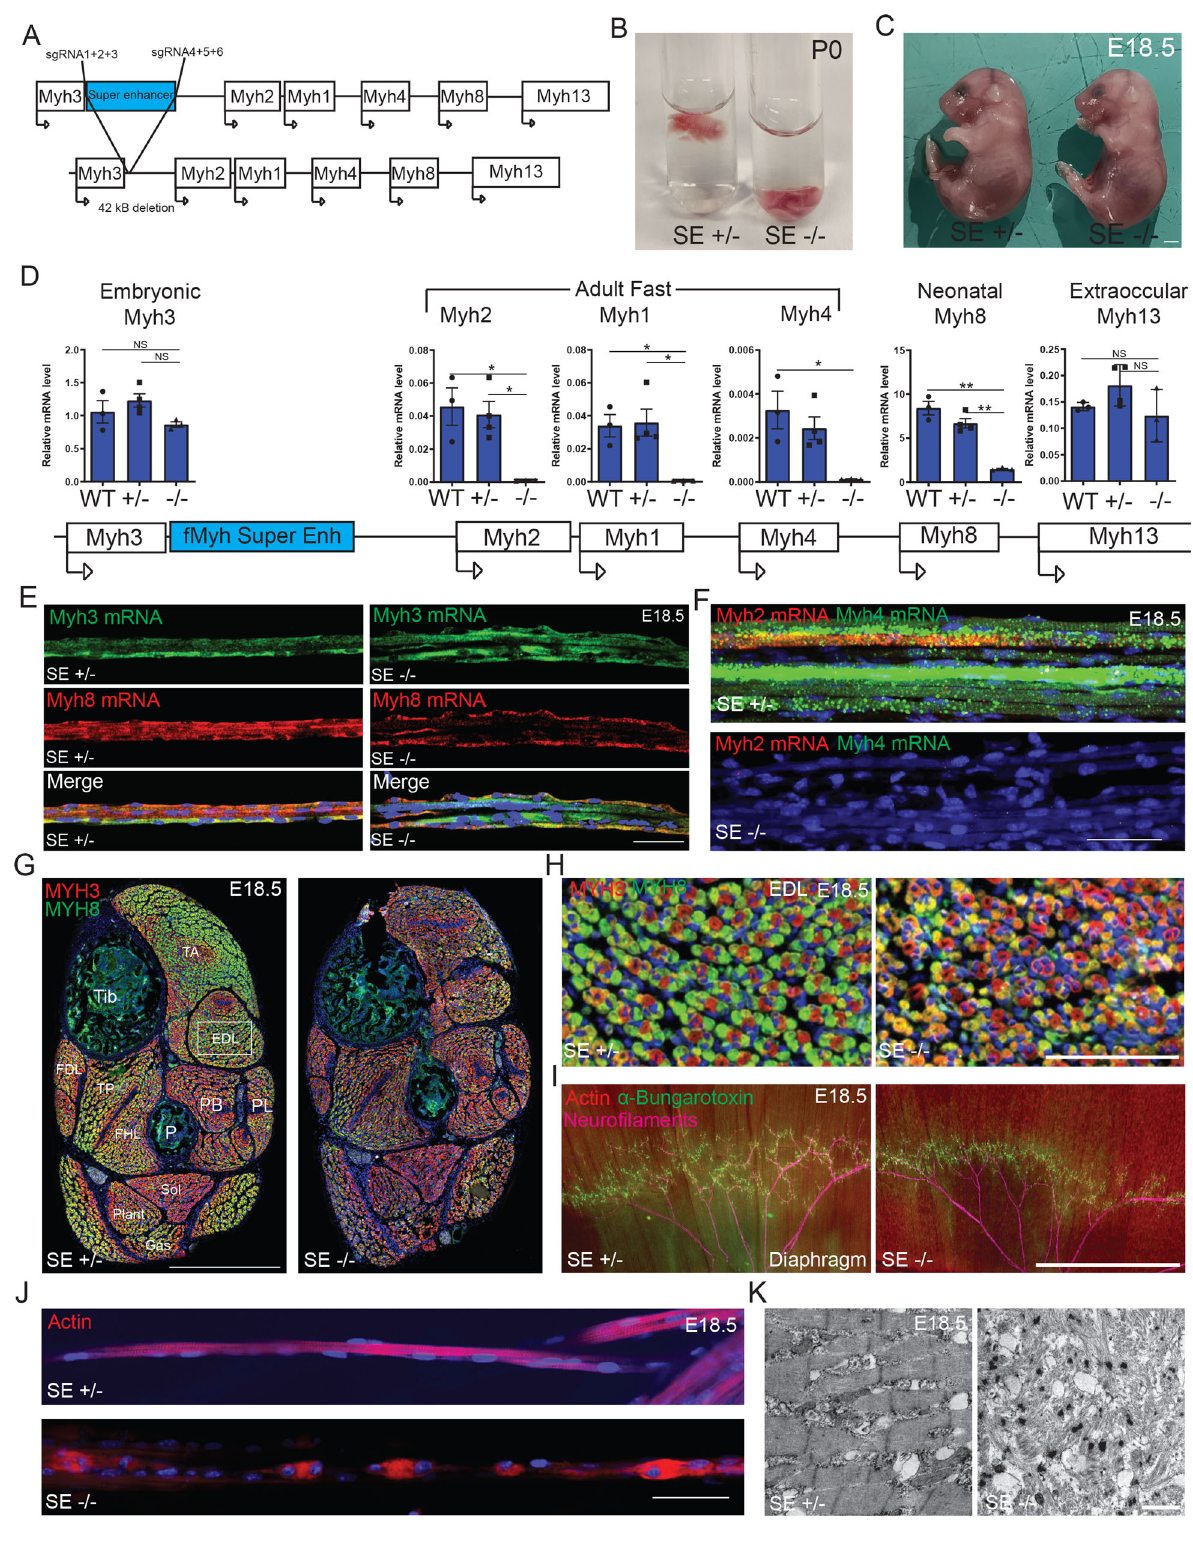
quanti fi ed by RT-qPCR on leg skeletal muscles (Fig. 3D – F). We detected at this embryonic stage regionalized low expression of adult f Myh along a few mutant fi bers (Fig. S7D), indicating that the Myh4 gene can be expressed in rare myonuclei in absence of the f Myh- SE. Thus, the f Myh- SE allows sustained expression of f Myh in the syncytium, although not all myonuclei at E18.5 have yet activated the expression of these adult forms 10 . Myh4 or Myh1